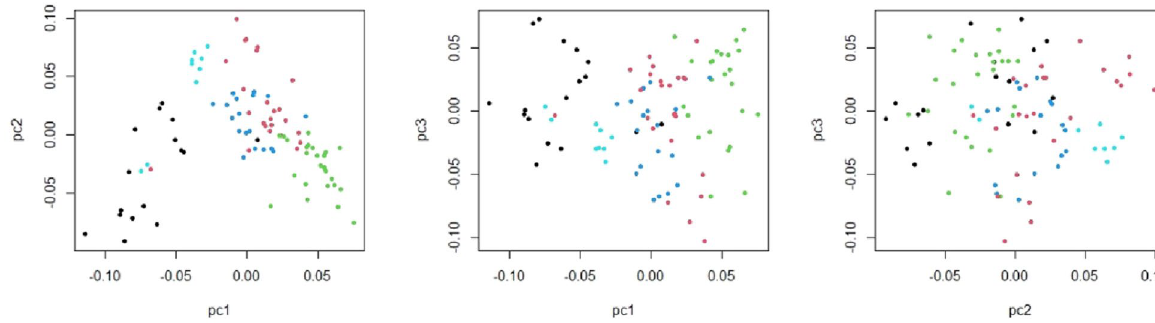
Figure 1. Multi-dimensional scaling (MDS) plots of the genotyping data, based on the first three PCs. Each dot is an animal and different dot colours represent clustering